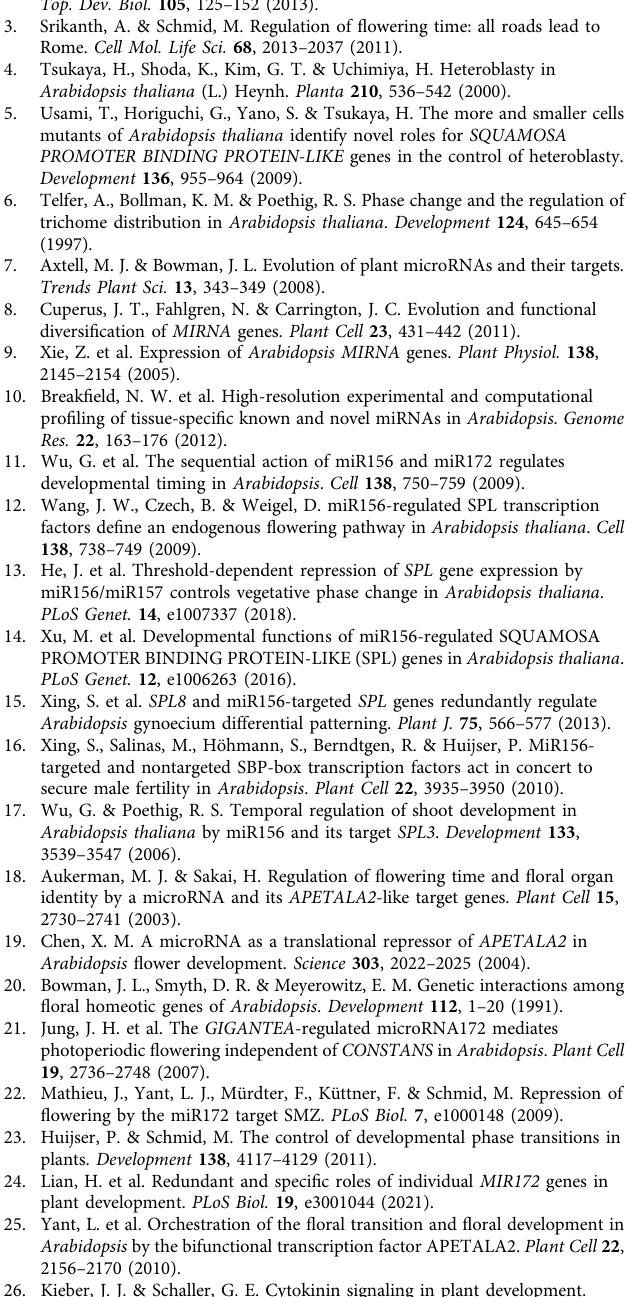
Supplementary Table 3. For the analyses of juvenile leaf number and the quanti- fi cation of miRNA abundance and gene expression in CK mutants, Arabidopsis plants were grown on soil with a 8h light/16 h dark cycle, at 22°C and 60% humidity and light intensities of 100 – 150 µmol m – 2 s – 1 . Ahk2,3 MIR172ox T1 plants were selected on ½ MS agar plates (0.22% (w/v) MS basal salt, 0.05% (w/v) MES, 0.5% (w/v) sucrose, 0.8% (w/v) agar, pH 5.7) containing 30 µg/ml